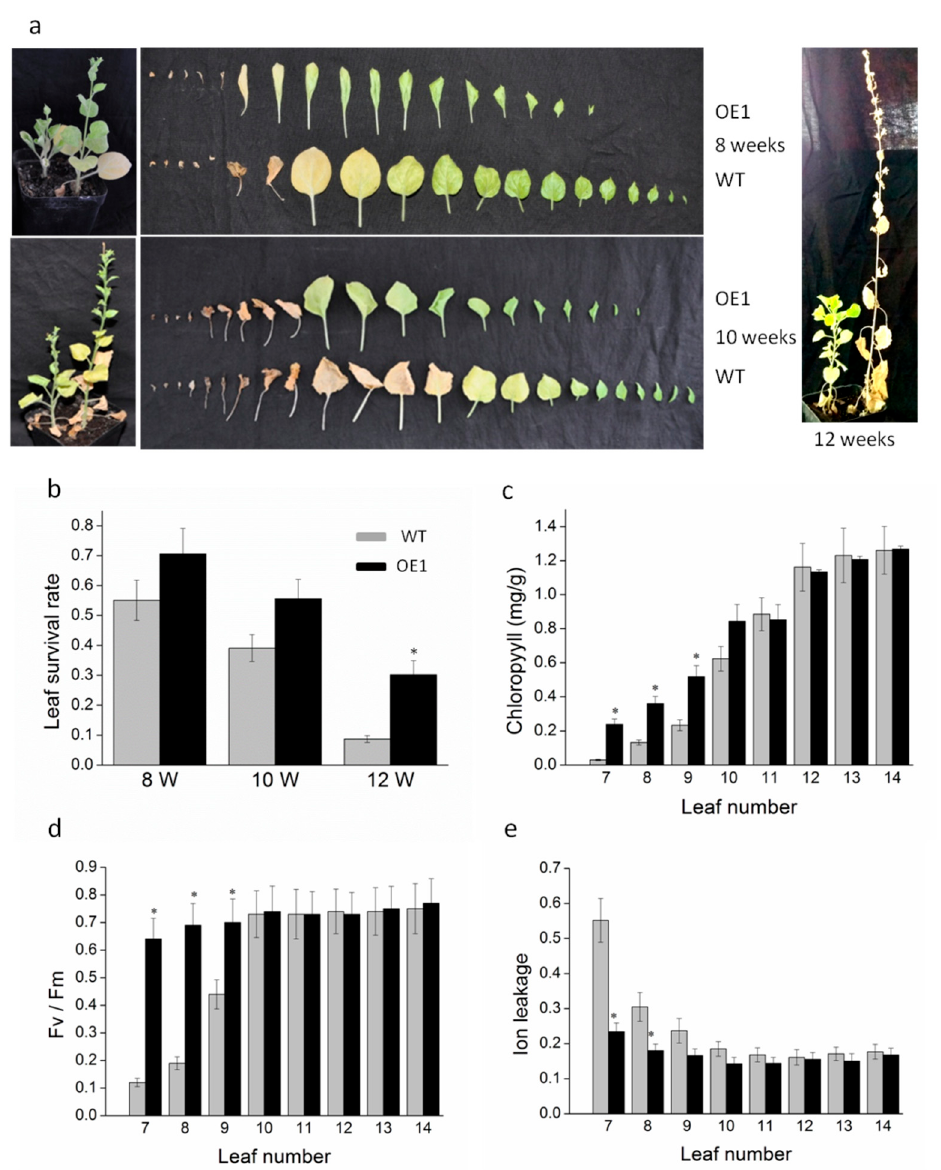
Figure 2. DRL1-over-expression delayed leaf senescence. ( a ) The phenotype of transgenic and wild-type (WT) tobacco plants at 8, 10, and 12 weeks. ( b – e ) Physiological analyses of leaves from transgenic plants. Leaf survival rate ( b ), chlorophyll concentration ( c ), ion leakage ( d ), and Fv / Fm ratio ( e ) were measured in WT and transgenic plants of the same age. Bars represent mean ± SD. Significant difference from the WT was confirmed by Tukey’s test [34,35] (* p < 0.05).